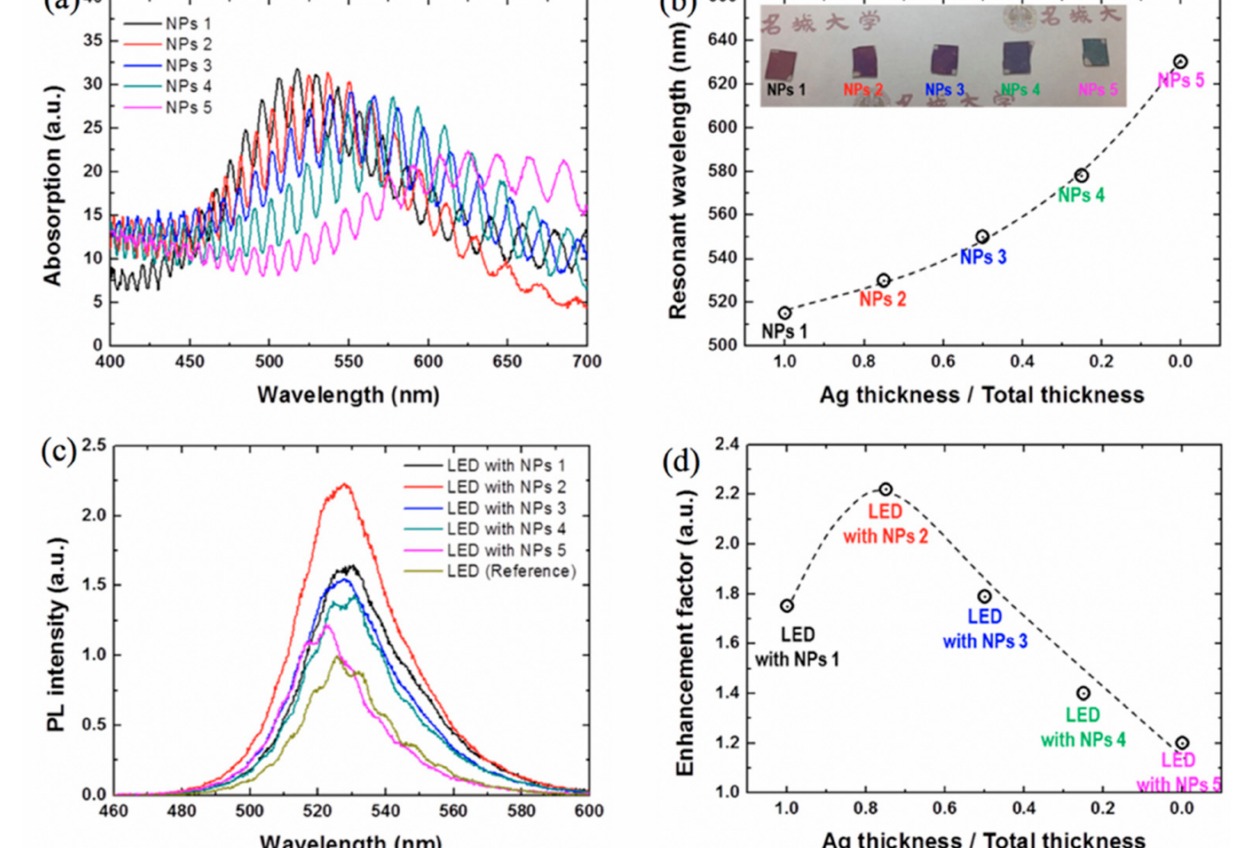
Figure 4. ( a ) Absorption spectra and ( b ) resonant wavelengths of the LSP modes for NPs of varying Au and Ag concentra- tions on the GaN layer. The inset shows the samples that have different colors due to different absorption properties. ( c ) PL spectra of the LEDs with and without NPs. ( d ) The enhancement factors of the LED with NPs. Reproduced from